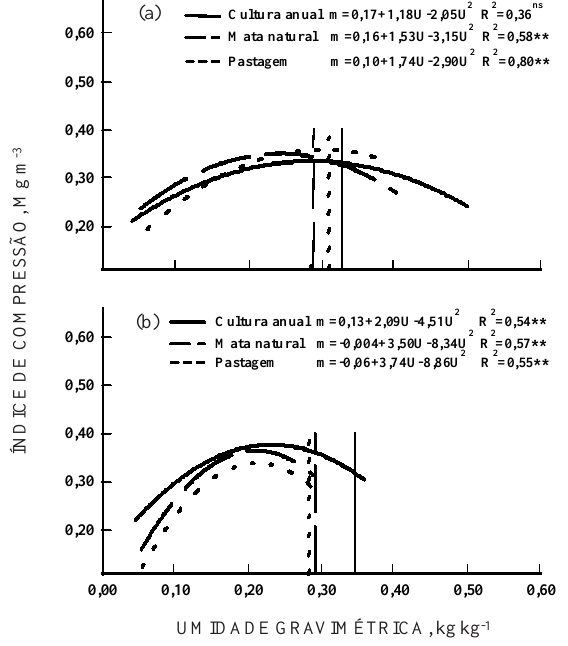
Figura 4. Relação entre o índice de compressão e a umidade gravimétrica para o Latossolo Roxo sob as condições de cultura anual, mata natural e pastagem, nas profundidades de 0-0,03 m (a) e 0,27-0,30 m (b), com n = 15 (as linhas verticais representam os respectivos limites de plasticidade, com três